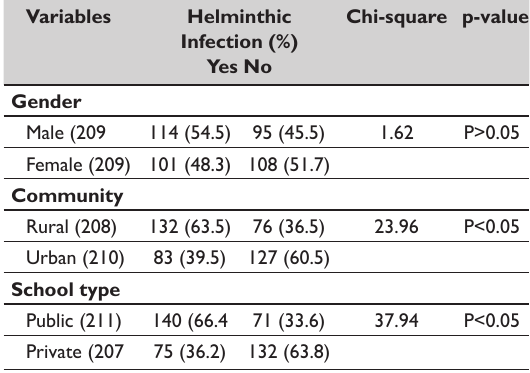
Table 2: Prevalence of intestinal parasitic